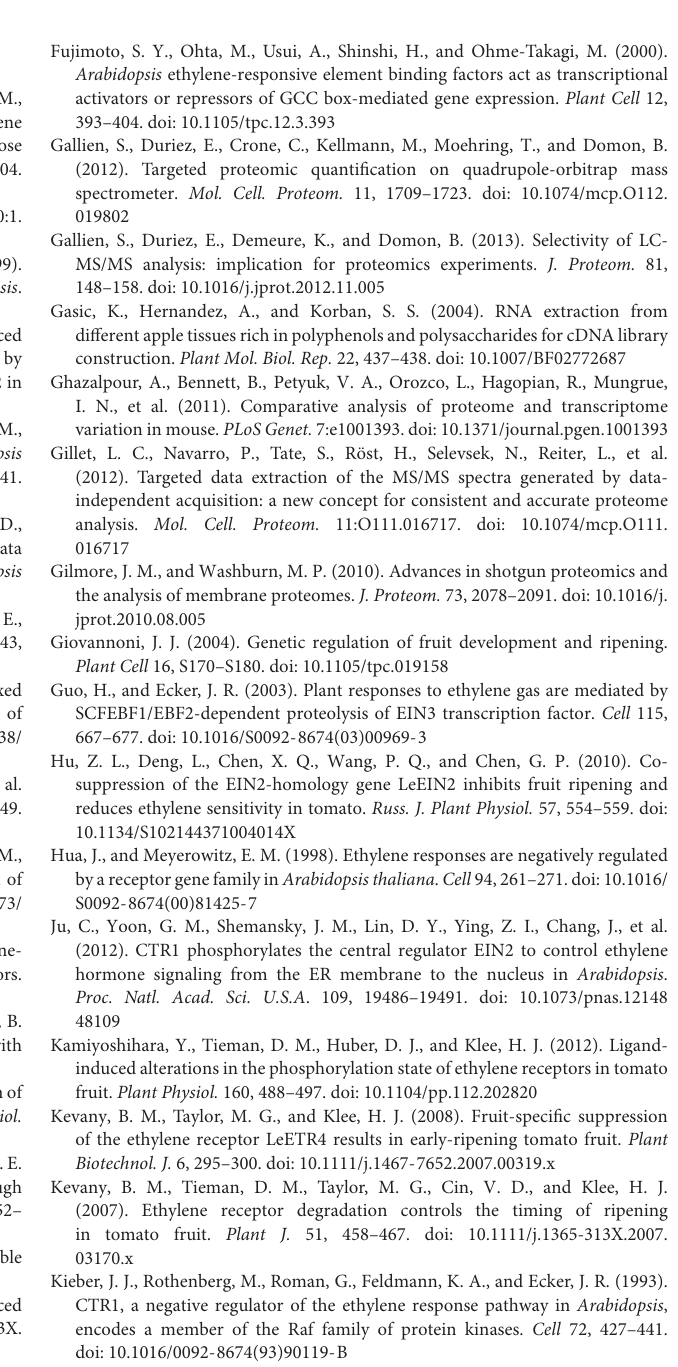
Uniprotannotated transmembrane domains are underlined, their possible phosphorylation sites are highlighted in green and their GAF domain, kinase domain and response regulatory domains are represented in green, blue and orange fonts, respectively. The peptides used for the quantifications of the proteins in the current study are highlighted in yellow. TABLE S5 | Cluster alignment of Q9S814 (AtEIN2) and Q6Q2C1 (SlEIN2) with the alignment tool of Uniprot. The C-terminal part of AtEIN2 is highlighted in green based on the results of Qiao et al. (2012). The two peptides of SlEIN2 identified and quantified in this work are highlighted in